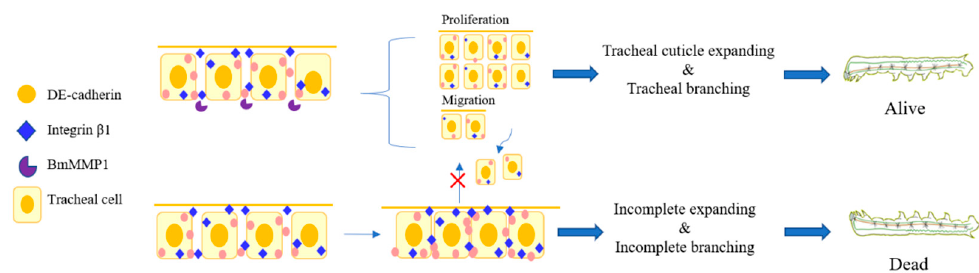
Figure 8. Model showing that BmMMP1 mediates tracheal branching in B. mori . The scissor images were obtained from were obtained from Microsoft PowerPoint Microsoft PowerPoint 2016.